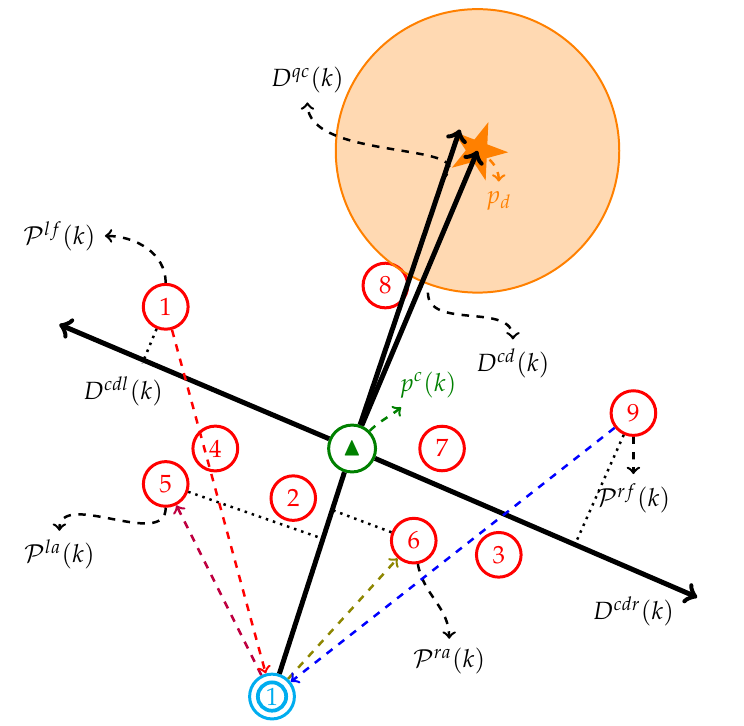
Figure 5. An example illustrating the definitions of D cd ( k ) , D cdl ( k ) , D cdr ( k ) , D qc ( k ) , P la ( k ) , P ra ( k ) , P lf ( k ) , and P rf ( k ) .